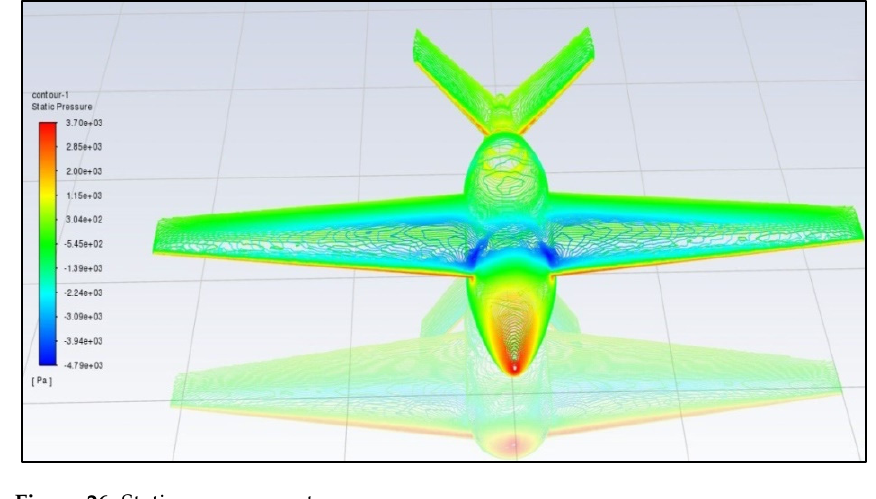
Figure 26. Static pressure contour.